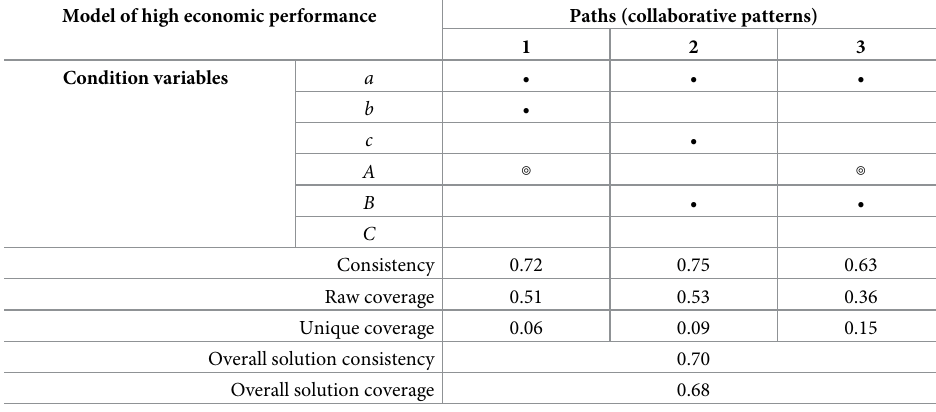
Table 7. The paths (collaborative patterns) to “high social/environmental